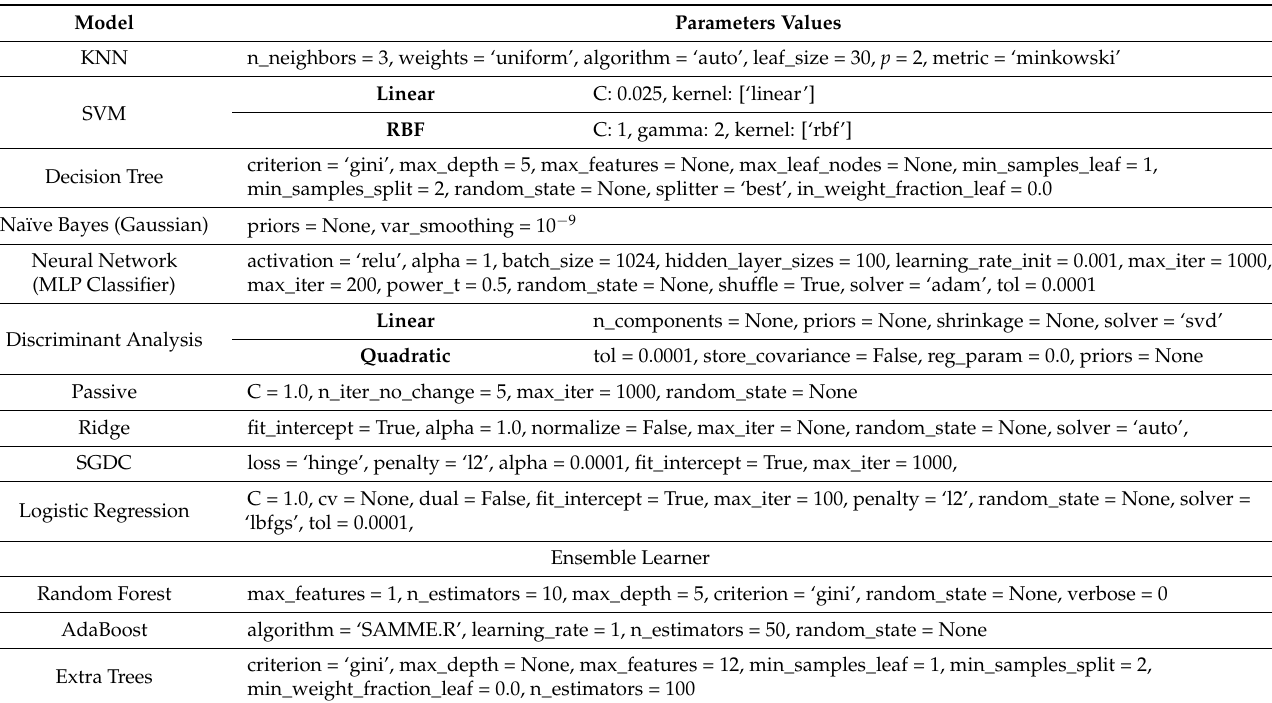
Table 3. Default parameters values for the machine learning